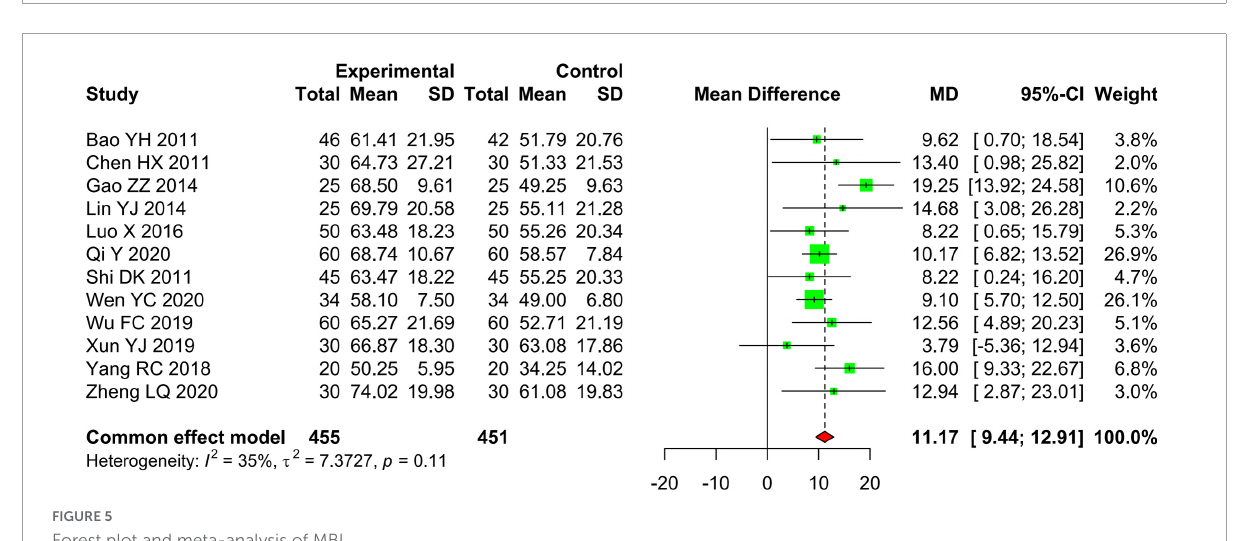
FIGURE4 Forest plot and meta-analysis of FMA-U.